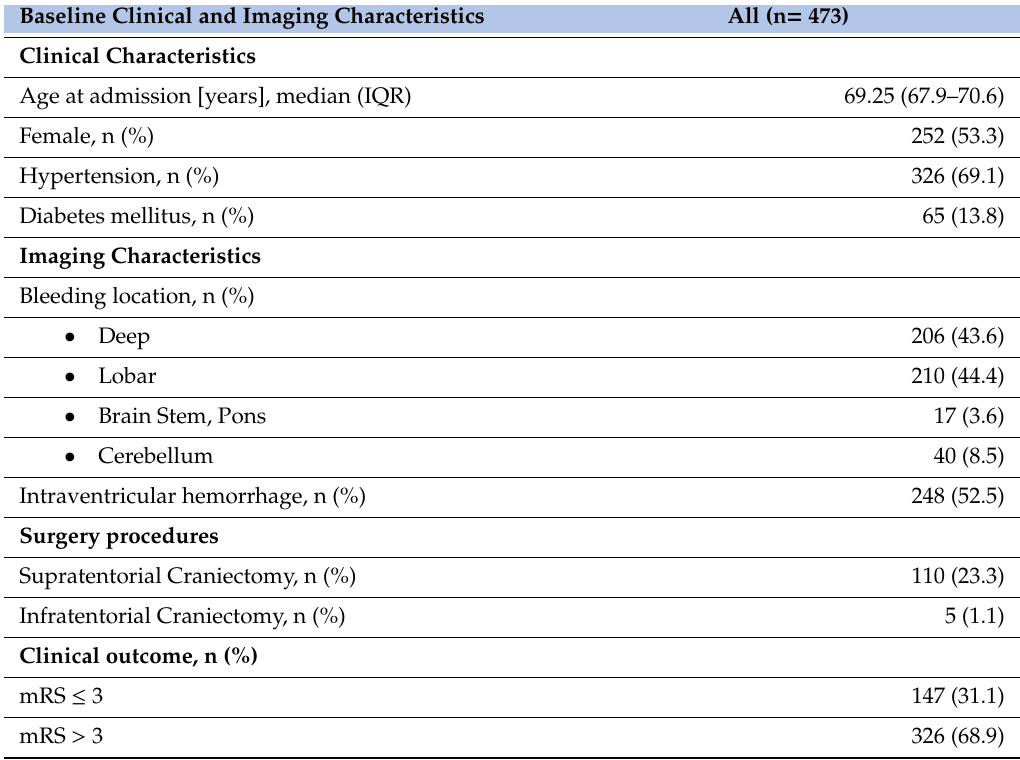
Table 1. Comparison of baseline demographic and radiological